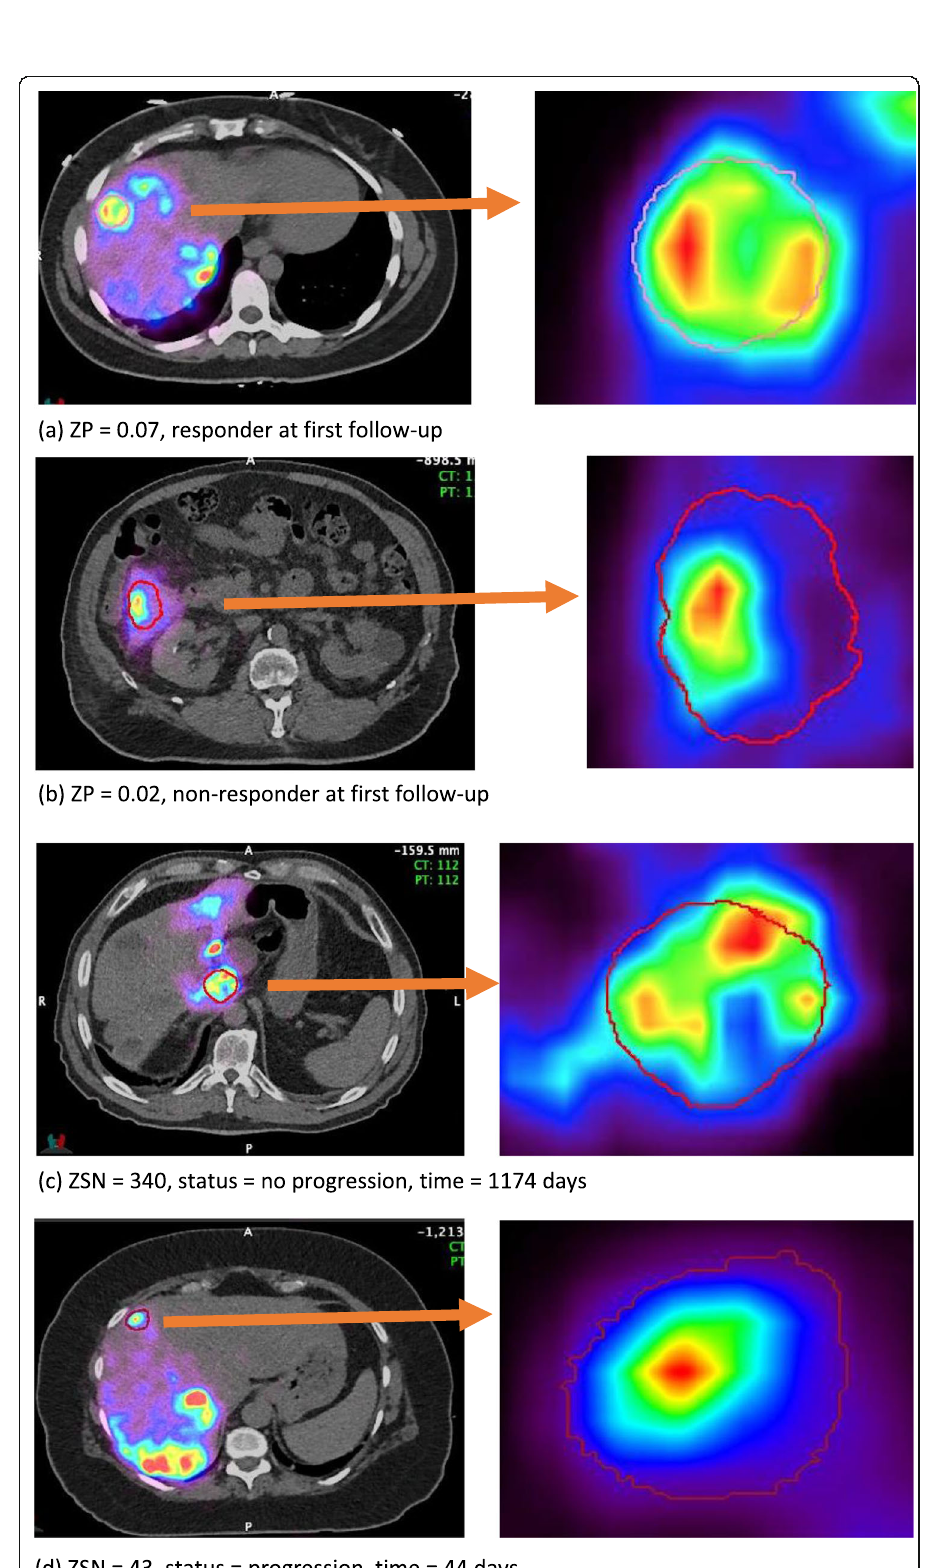
Fig. 7 (See legend on next